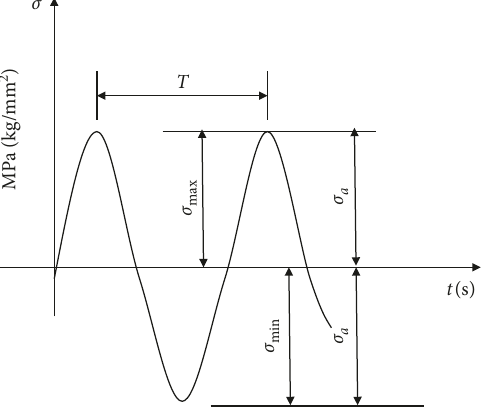
Figure 2: Fatigue bending.